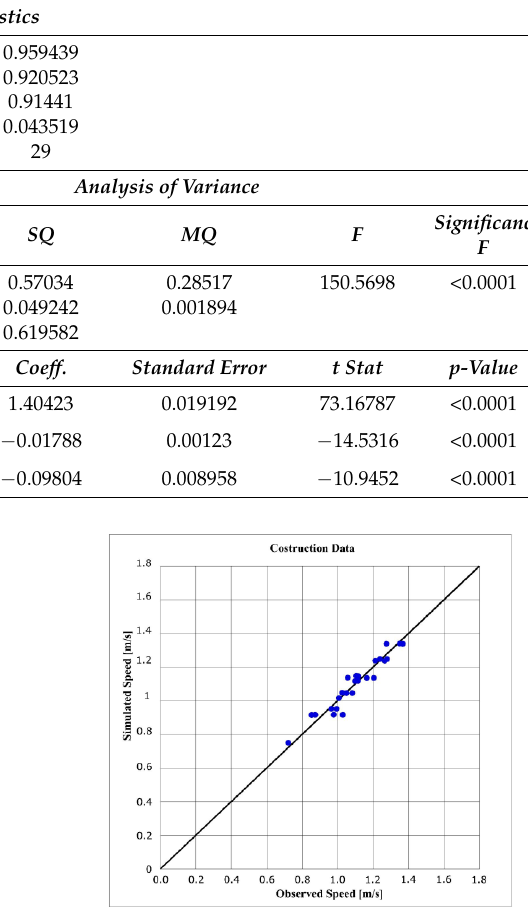
Figure 10. Global model. Comparison between the observed and simulated speeds.